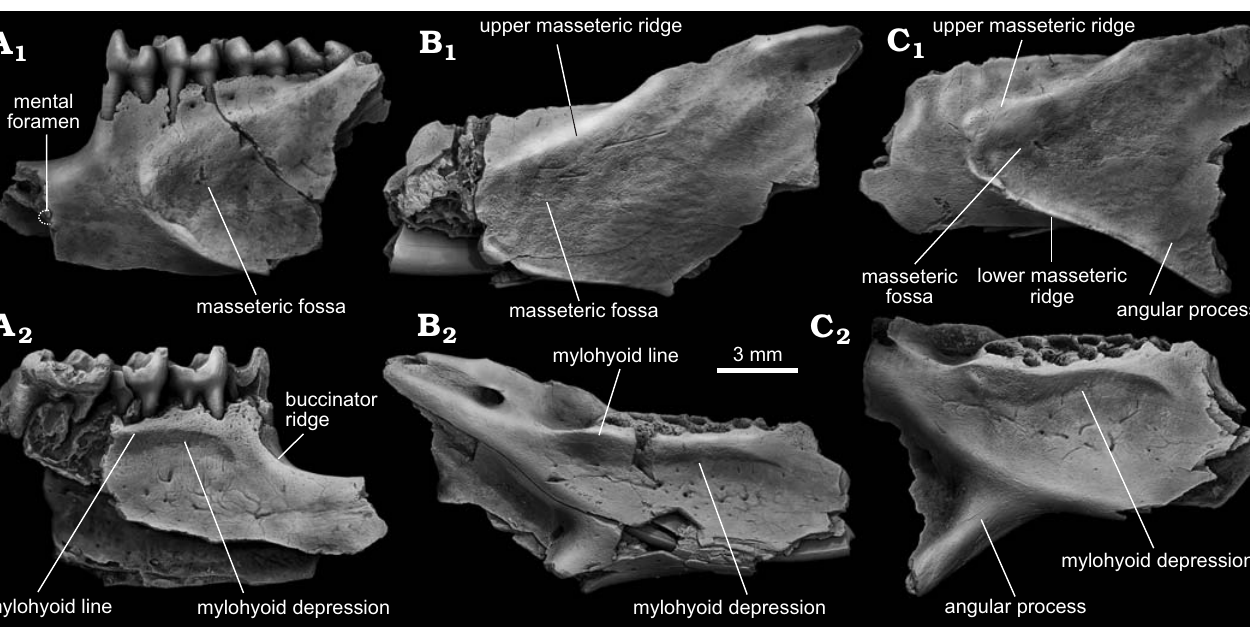
Fig. 5. Ground squirrel Spermophilus praecox sp. nov. from the Early Pleistocene of southern Ukraine: Kotlovina 3 (A) and Morskoy (B, C); mandibles in lateral (A 1 –C 1 ), and medial (A 2 –C 2 ) views. A . ZIN 105163/1. B . ZIN NMNHU-P MoT-63 (inverted). C . NMNHU-P